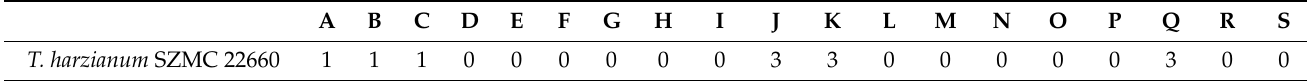
Table 1. Extracellular enzyme activities as determined with API-ZYM system (alkaline phosphatase (A), esterase C4 (B), esterase lipase C8 (C), lipase C14 (D), leucine arylamidase (E), valine arylamidase (F), cysteine arylamidase (G), trypsin (H), α -chymotripsin (I), acid phosphatase (J), naphthol-AS-BI-phosphohydrolase (K), α -galactosidase (L), β -galactosidase